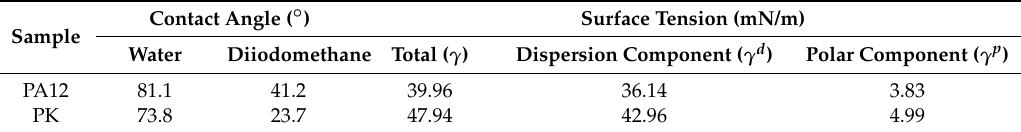
Table 1. Contact angle and surface tension of PA12 and